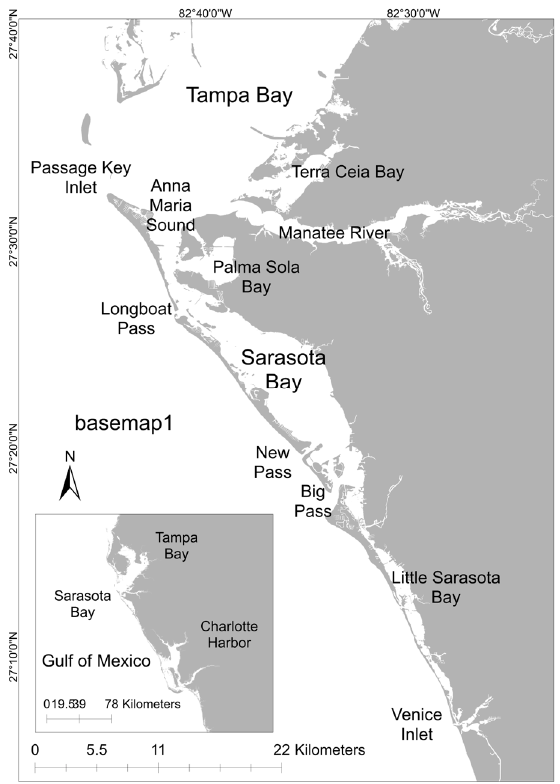
Figure 1. Sarasota Bay study area. The same area was utilized for photo-identification efforts and urine sampling sites.